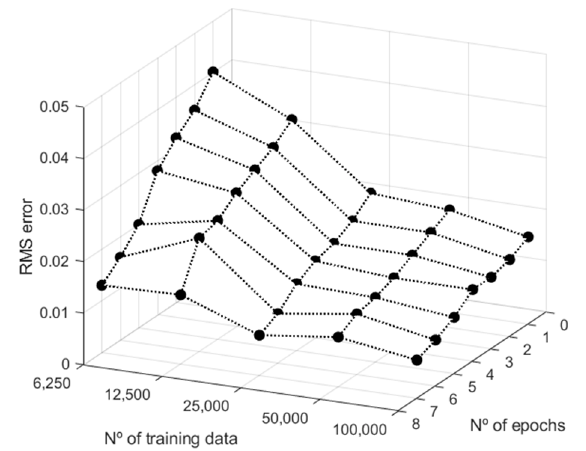
Figure 5. RMS error at di ff erent Training Data Sizes.